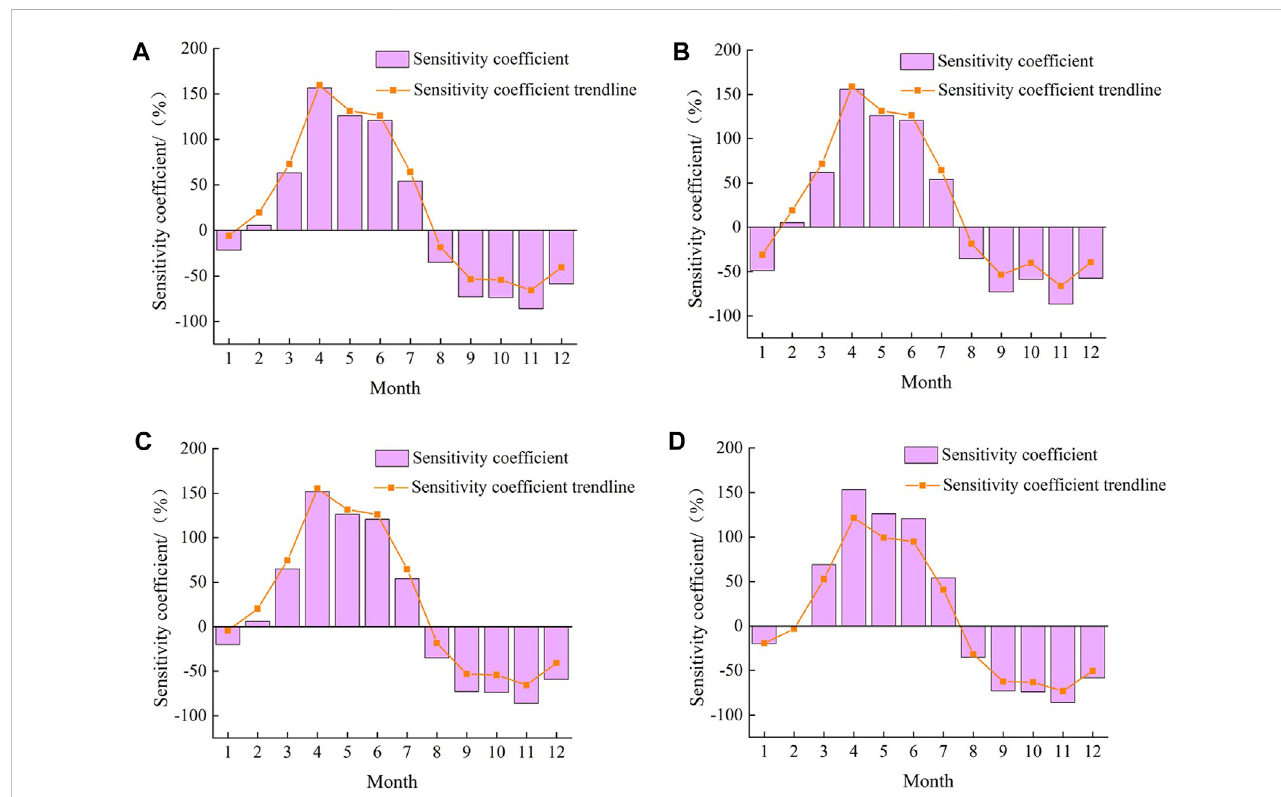
FIGURE 8 Monthly variation characteristics of the sensitivity coef fi cients of the four sections. (A) Niya Reservoir. (B) 818 Canal. (C) Niya Station. (D) Niya